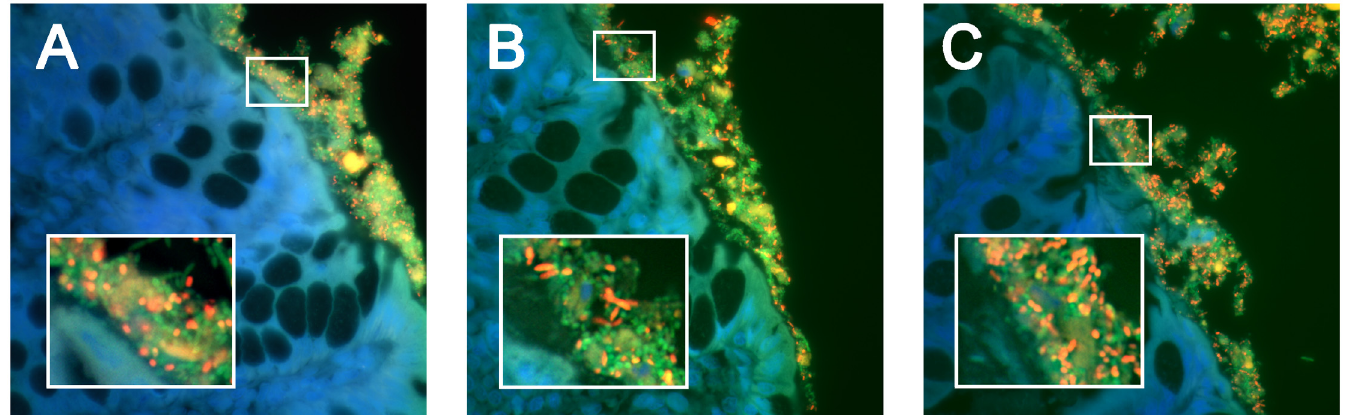
Fig 3. FISH of canine endoscopic biopsies. Triple color FISH identifies bacterial organisms present in biofilms adherent to the colonic epithelia in dogs with inflammatory bowel disease (A), granulomatous colitis (B), and colorectal cancer (C). Bacteroides (Bac303-Cy3 probe – panel A), E . coli (Ec-Cy3 probe – panel B), and Eubacterium rectale (Erec482-Cy3 – panel C) populations appear orange against green and blue backgrounds. All other bacteria that hybridize exclusively with the universal probe (Eub338-FITC) appear green. DAPI-stained colonic mucosa with goblet cells appears blue.